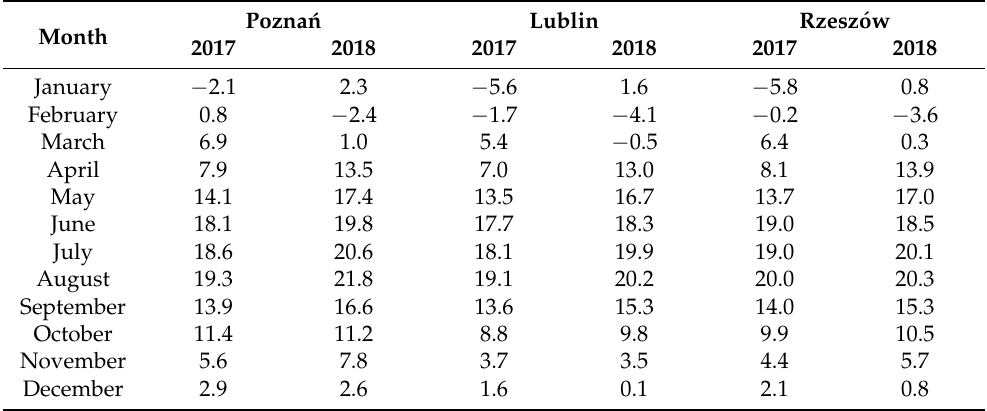
Table 1. The average monthly temperature in 2017–2018 at individual research